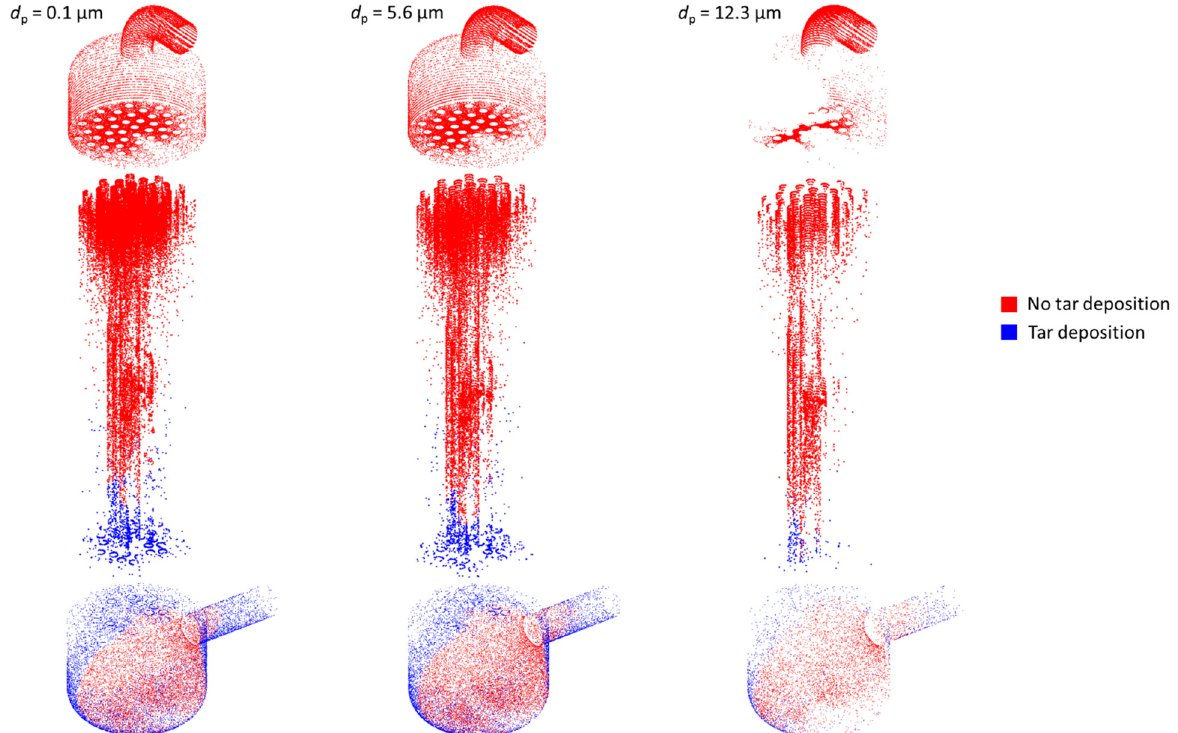
Figure 9. Tar class 5 deposition patterns according to droplet diameter.